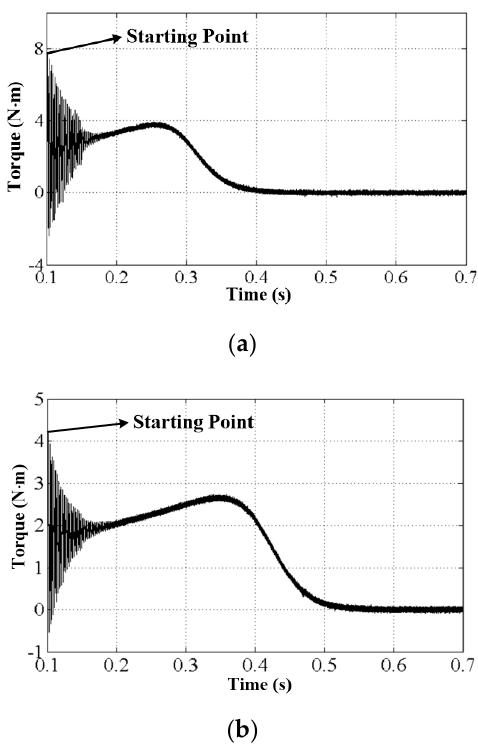
Figure 12. The experimental torque comparison. ( a ) The torque with the direct starting. ( b ) The torque with the series resistance starting.